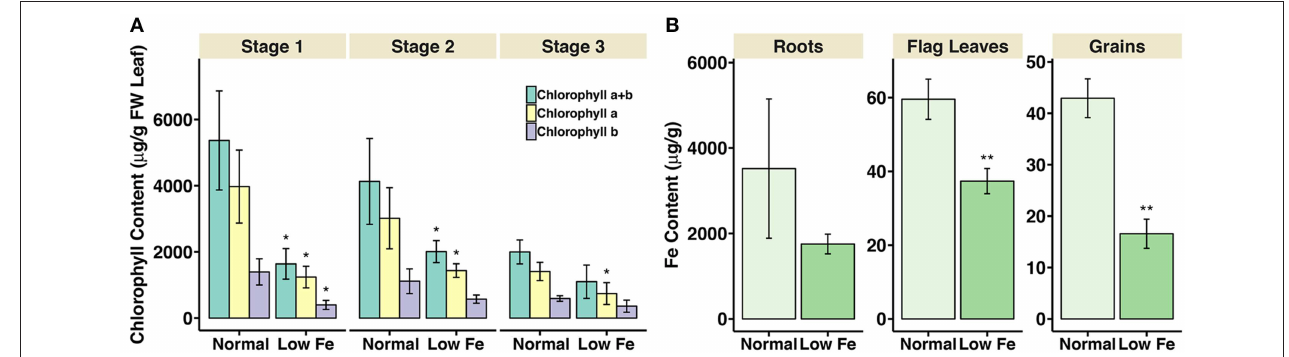
FIGURE 1 | Chlorophyll content in flag leaves and iron concentration in roots, flag leaves and grains of iron deficiency stressed plants. (A) Total chlorophyll content (chlorophyll a + b), chlorophyll a, and chlorophyll b content are presented. Values are the mean ± standard deviation of the three biological replicates (* p ≤